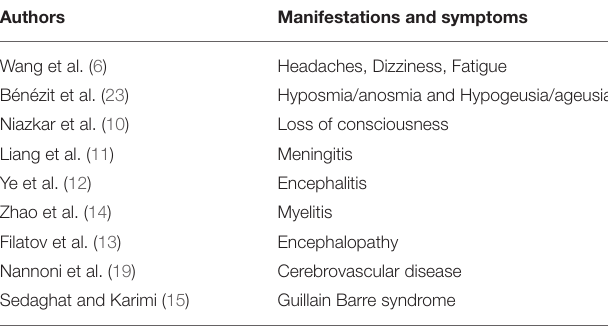
TABLE 1 | Neurological manifestations and symptoms in patients with